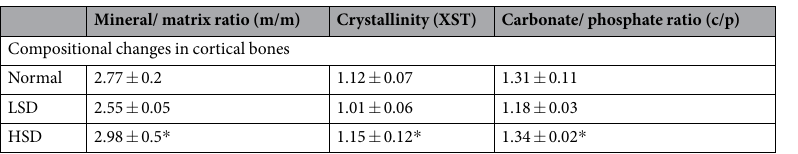
Table 3. High dietary salt intake decreases heterogenity of bones. Tabular representation of compositional changes in bones as detected by FTIR for bone mineral/ organic matrix ratio (m/m), crystallininty (XST) and carbonate to phosphate ratio (c/p) of normal, low salt diet (LSD) and high salt diet groups (HSD). The results were evaluated by using ANOVA with subsequent comparisons by Student t test for paired or nonpaired data, as appropriate. Analysis was performed using Sigma plot software (Systat Software, Inc., Germany). Values are reported as mean ± SEM (n = 10) and similar results were obtained in three independent experiments. Statistical significance was defined as p ≤ 0.05 ( * p ≤ 0.05, ** p ≤ 0.01) with respect to low salt diet